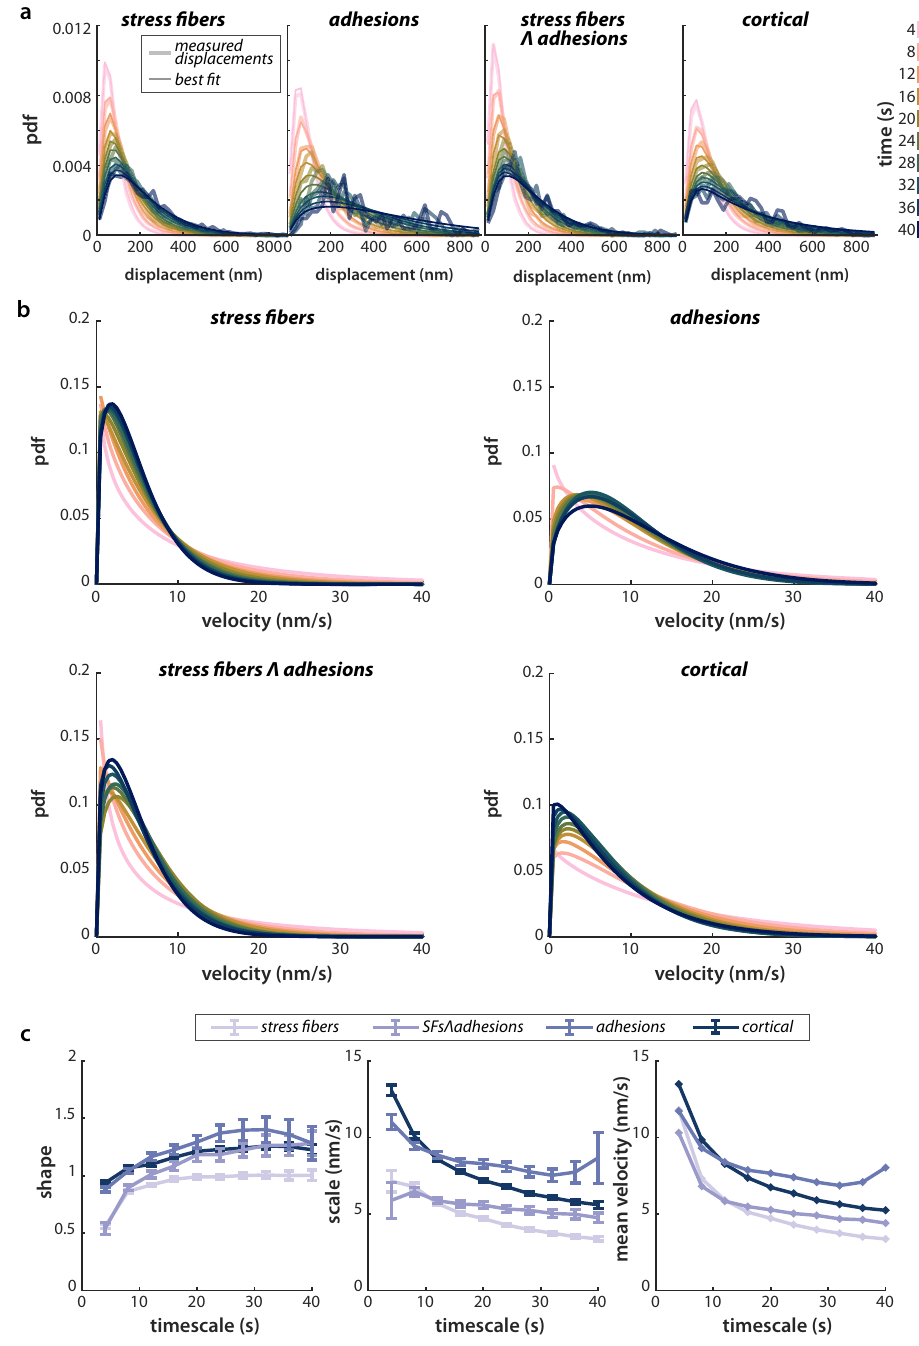
Fig. 3 Inferred distributions of F-actin velocities show distinct behavior inside vs. outside SFs. a Puncta were automatically classi fi ed into subpopulations, corresponding to the four mutually-exclusive combinations of (±) stress fi bers and (±) adhesions: the cortical population is taken to be F-actin outside both stress fi bers and adhesions. Displacements for each subpopulation, along with best fi ts, are shown for varying time intervals. The distribution of displacements is calculated for timescales ranging from 2 s to 40 s, in 2 s intervals. Only every other time interval is shown for clarity. b The inferred velocity distributions corresponding to the measured distance distributions in a , assuming that underlying displacements follow a Weibull distribution. Example data and fi ts in a , b are for representative from one experiment, n = 9 cells. c Left, center: Fit parameters for the Weibull distribution fi ts. Error bars show the 95% con fi dence interval for each parameter, determined by normal approximation (see Methods, Model Fitting). Right: the average velocity for each population and timescale, calculated from the best- fi t Weibull distribution. The best fi t parameters in ( c ) represent the average over four experimental replicates, comprising 32 cells in total. Source data for all plots are provided in the Source Data fi